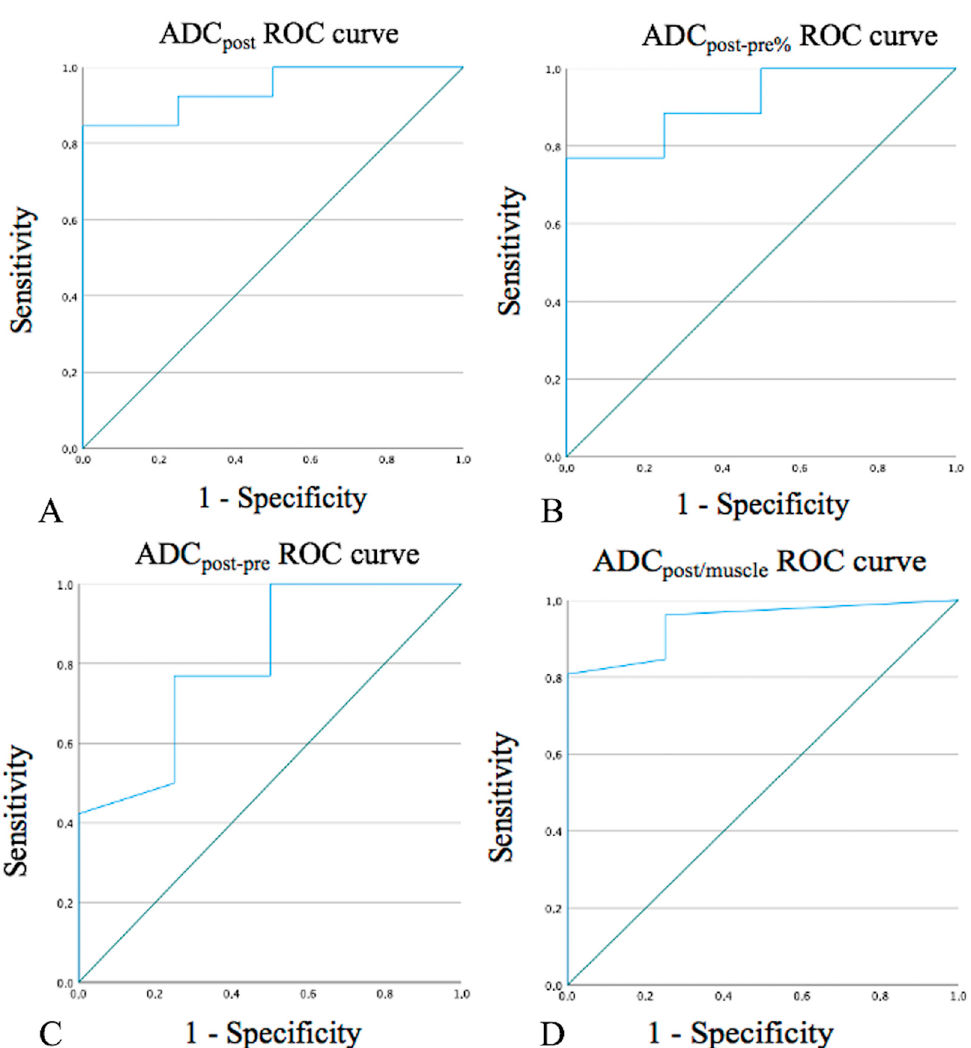
Figure 1. Receiver operating characteristic (ROC) curves for ADCpost values ( A ), ADCpost-pre% ( B ), ADCpost-pre values ( C ), and ADCpost/muscle values ( D ). ADC: apparent diffusion coefficient. ADCpost: residual tissue mean ADC